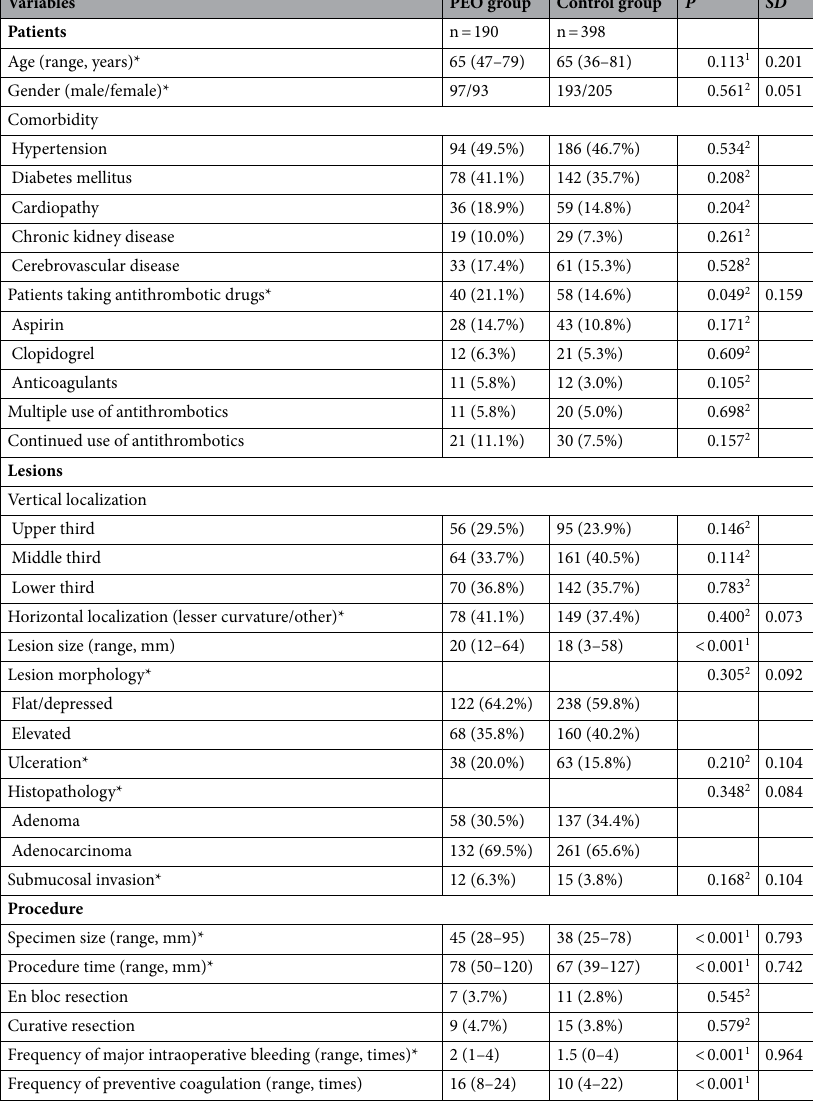
Table 1. Baseline characteristics of patients before propensity score matching. *Variables included in propensity score matching as matching factors. 1 Mann–Whitney U test. 2 χ 2